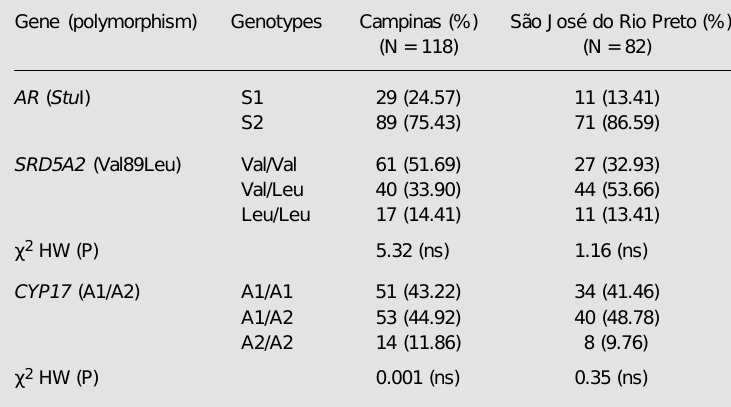
Table 1. Genotype distribution of AR , SRD5A2 and CYP17